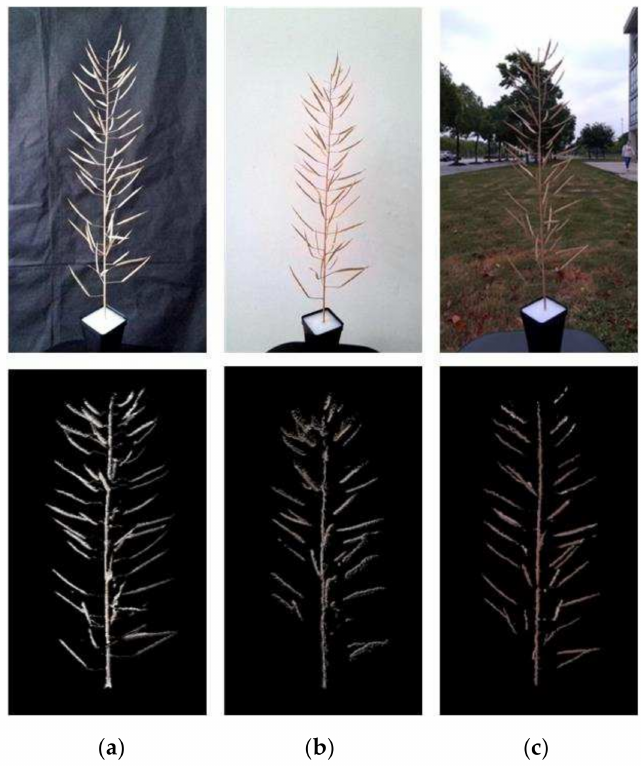
Figure 6. Comparison of different backgrounds ( a ) Indoor black background. ( b ) Indoor white background. ( c ) Outdoor background.